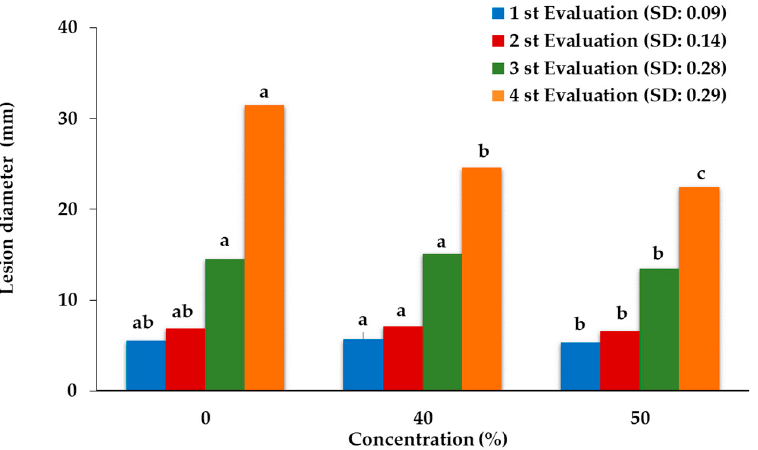
Figure 9. Effect of curative application of ethanolic extracts of Dipteryx punctata and coumarin pattern on lesion diameter, in the four evaluations carried out during the test. Means followed by the same lowercase letters in the columns do not differ from each other by Tukey’s test ( ≤ 0.05). SD = standard deviation.